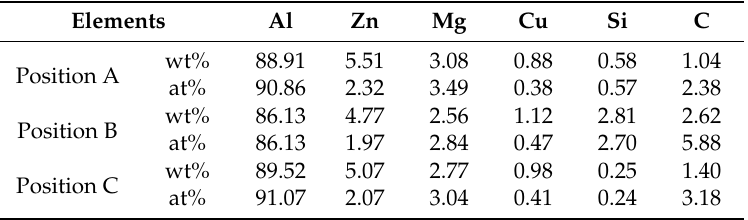
Table 1. Energy dispersive X-ray spectrometry (EDX) results in different locations of the thixoformed part soaked for 10 min at 590 °C.